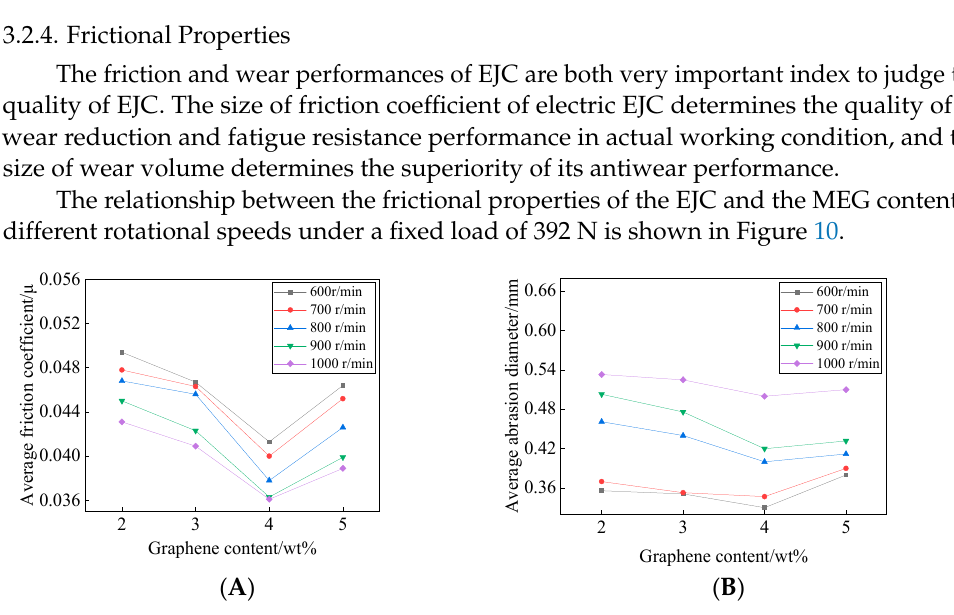
friction coefficient; ( B ) Average abrasion